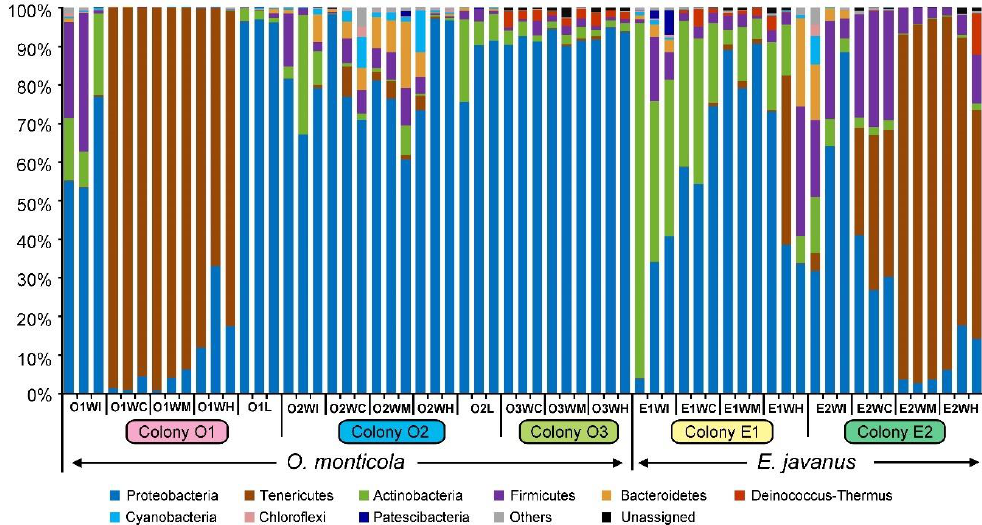
Figure 1. Bacterial communities of two ponerine ant species and their colonies at the phylum level. O1, O2, and O3, three colonies of Odontomachus monticola ; E1 and E2, two colonies of Ectomomyrmex javanus . WI, the infrabuccal pockets of workers; WC, the crop of workers; WM, the midguts of workers; WH, the hindguts of workers; L, larvae. Sample names are listed in Table 1 .